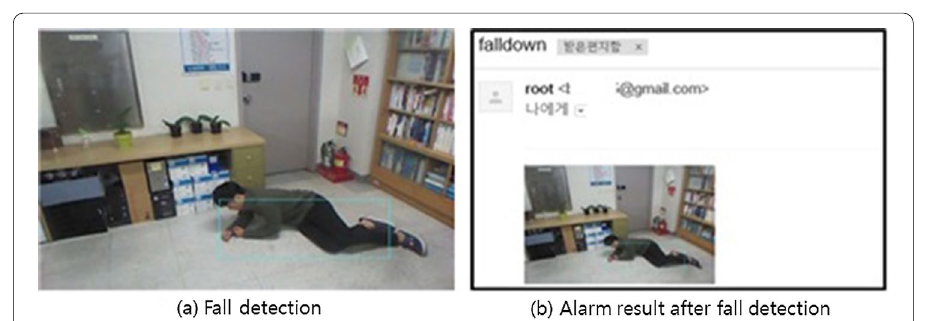
Fig. 20 Notify in case of an abnormal situation